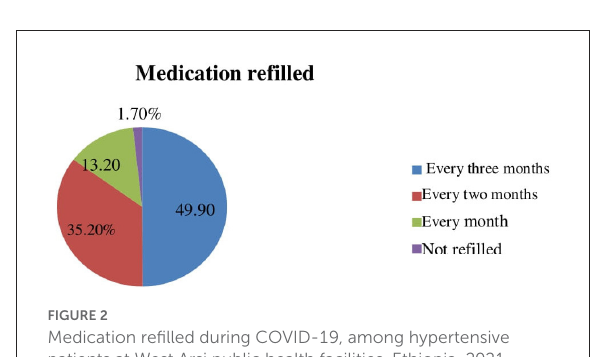
FIGURE2 Medication refilled during COVID-19, among hypertensive patients at West Arsi public health facilities, Ethiopia,